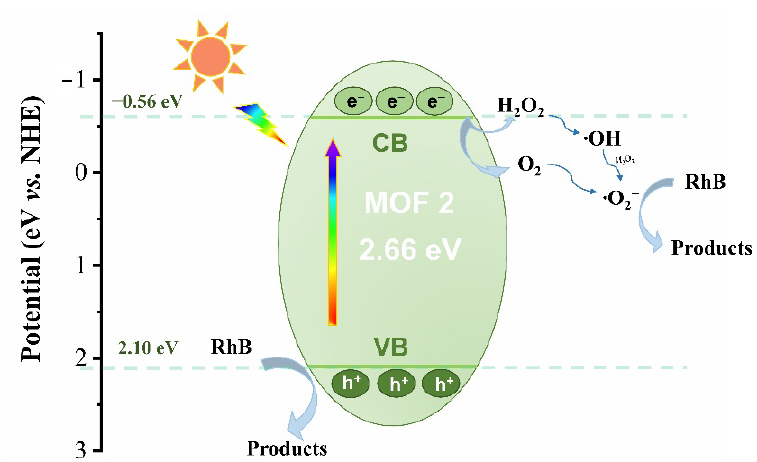
Figure 6. Mott Schottky plot of MOF 2 under varied frequencies.